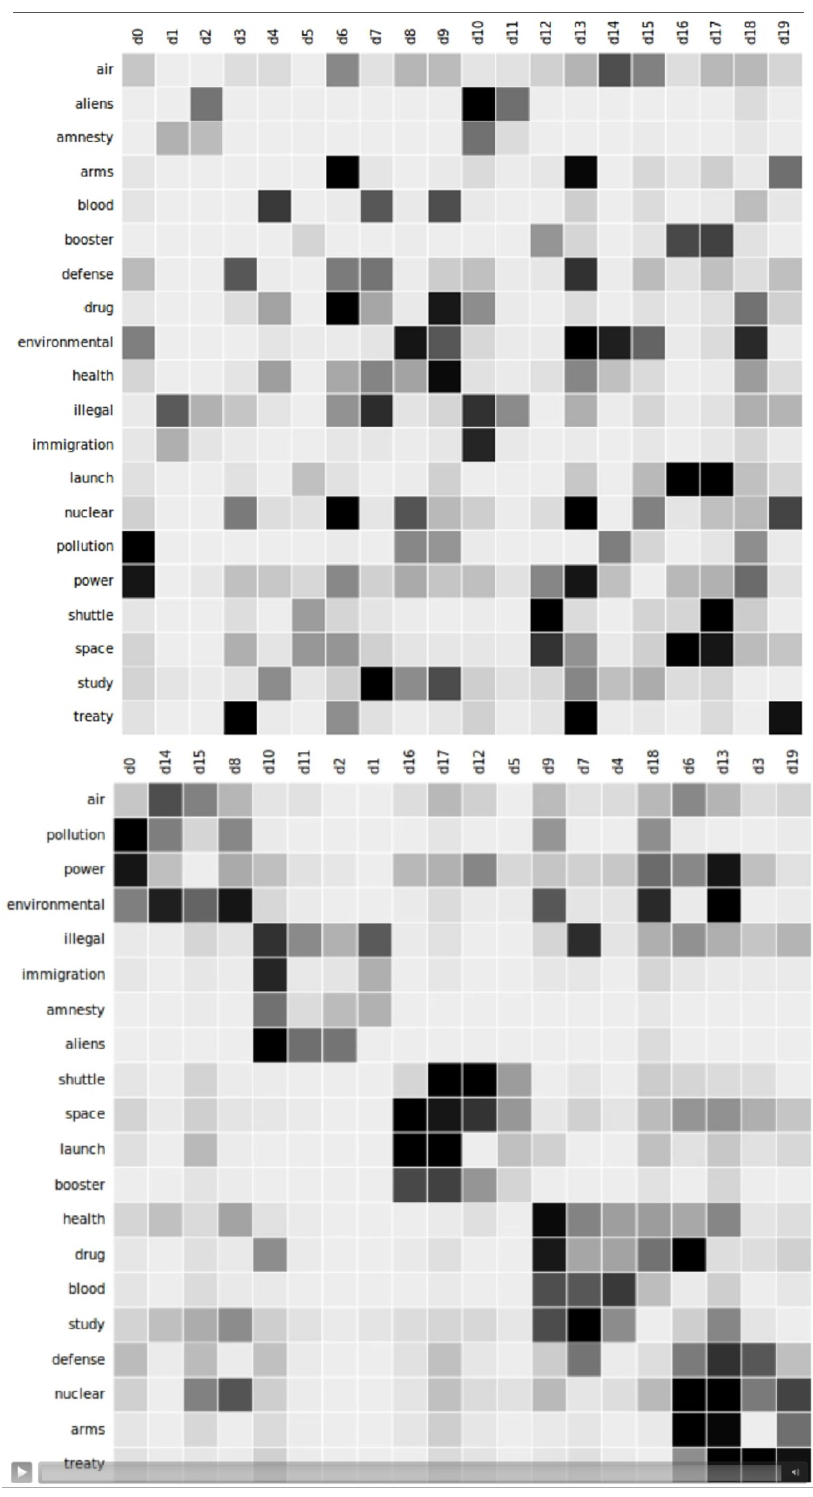
Figure 10. Top: data matriz uncomputed. Bottom: data matrix after being computed. Cristoph Carl Kling. Animation of the topic detection process in a document-word matrix (2017). Available on: https://commons.wikimedia.org/wiki/File:Topic_detection_in_a_document-word_matrix.gif (accessed on 28 July 2022) (screenshot).